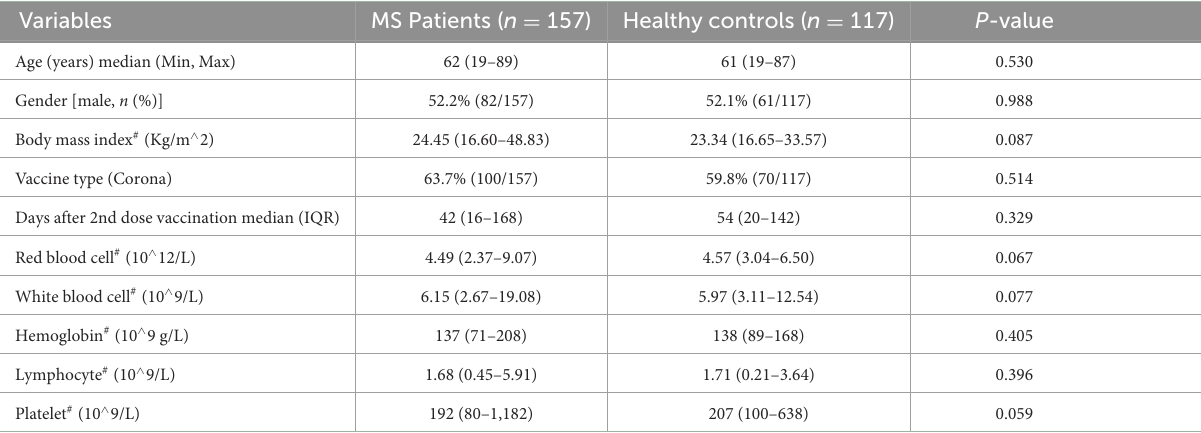
TABLE 1 Characteristic of MS patients and health controls. Variables